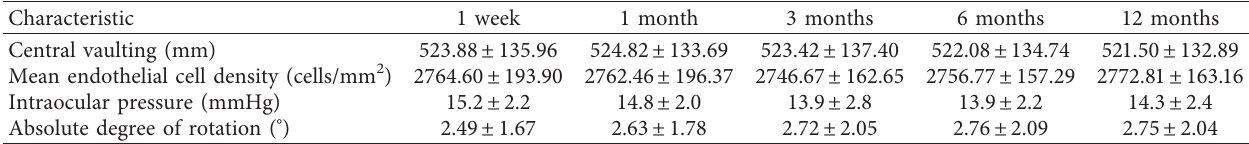
Table 3: Binary logistic regression analysis to evaluate the risk factors for TICL rotation at 12 months after surgery.